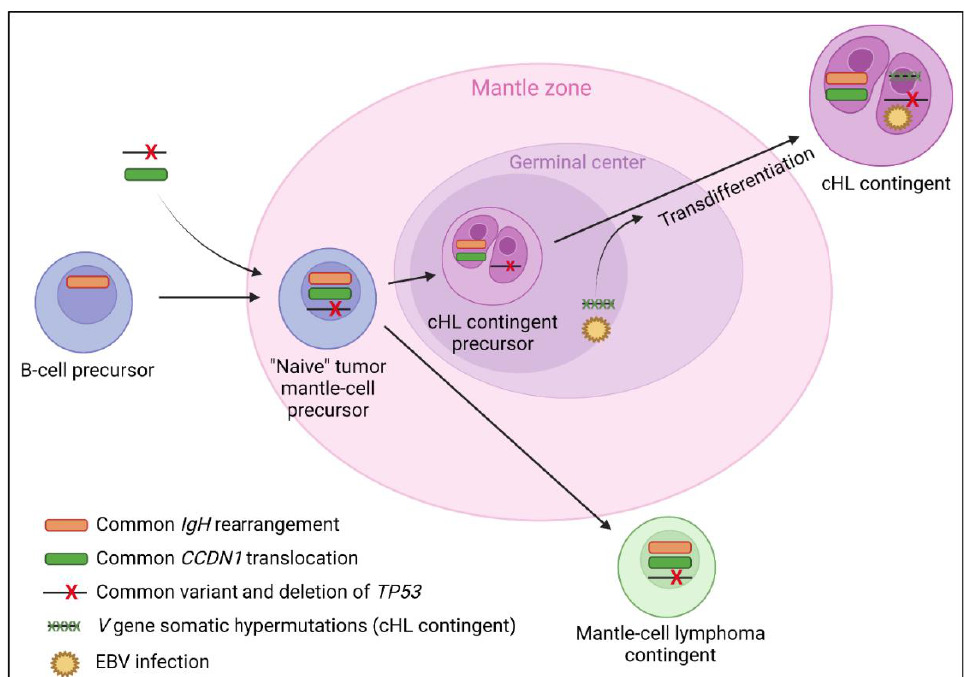
Figure 4. Suggested lymphomagenesis model for classical Hodgkin lymphoma (cHL)/mantle cell composite lymphomas. The frequent presence of a mantle cell lymphoma in patient personal history